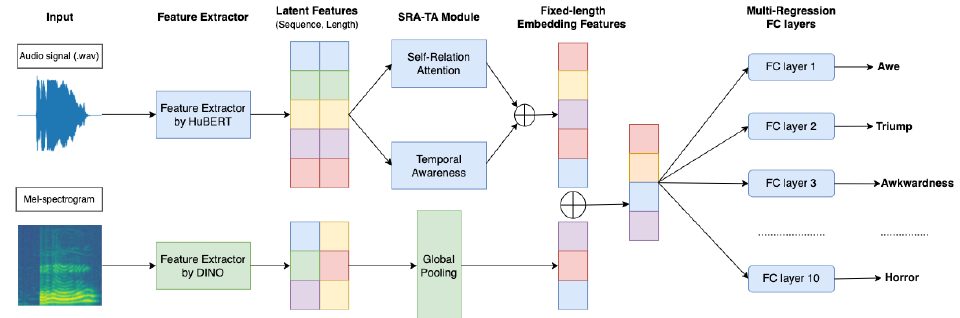
Figure 1. Overall architecture of our proposed method, which ⊕ means concatenation of